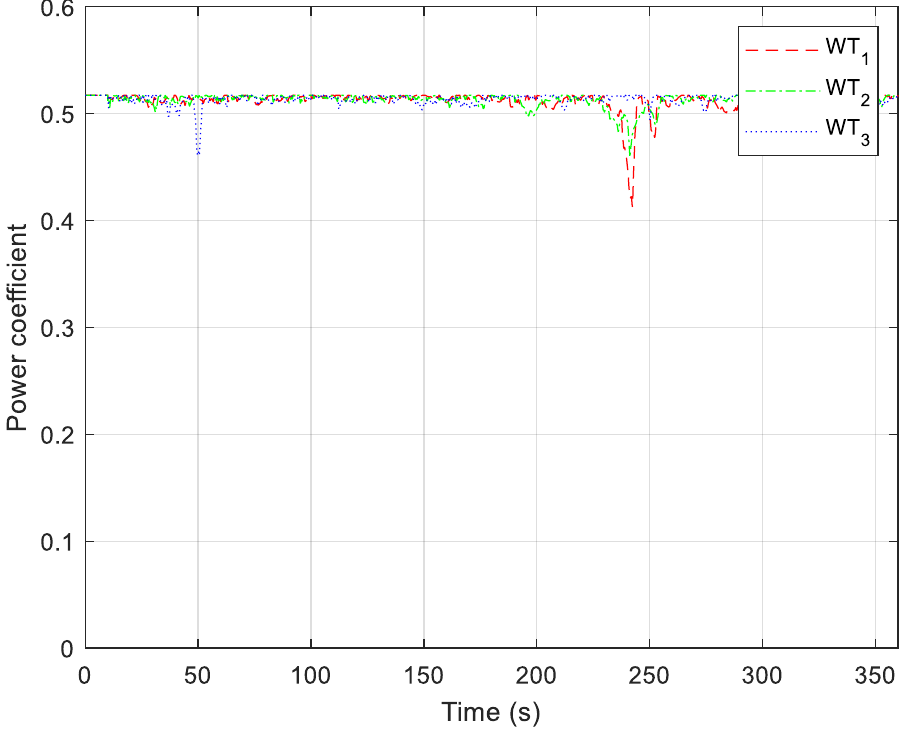
Figure 21. Power coefficient C p of the wind turbines (random wind disturbance).